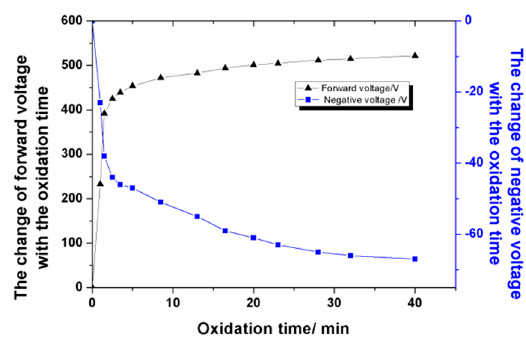
Figure 2. The change of voltage with the oxidation time.